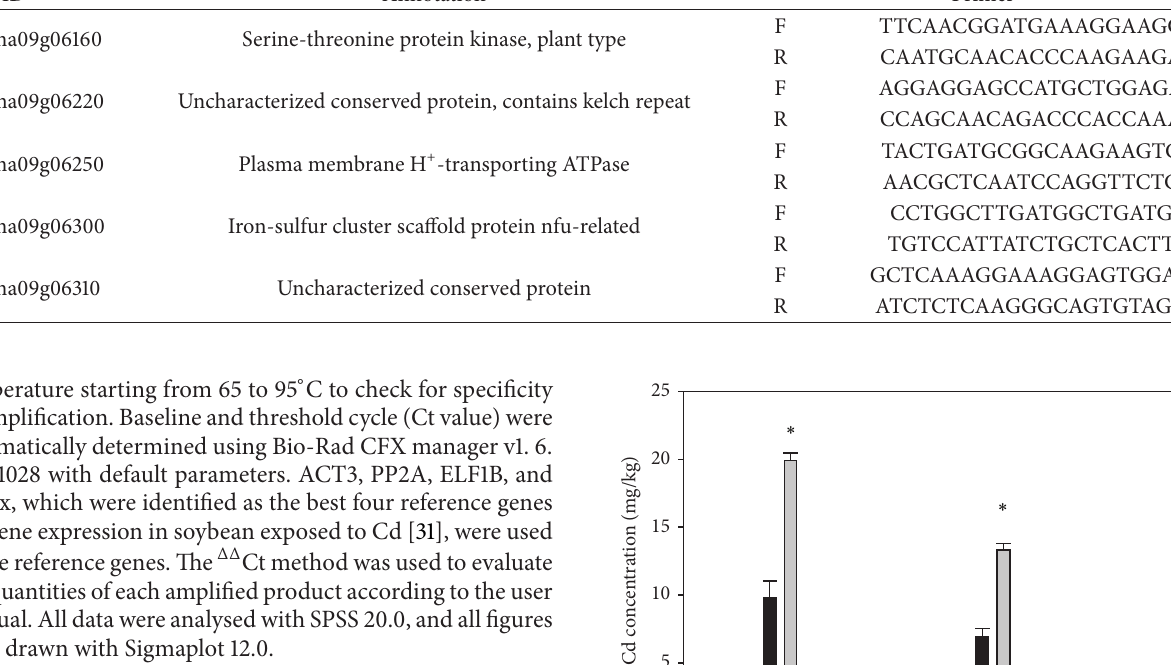
Table 1: The genes located in original region of major locus Cda1 or QTL were analyzed for expression pattern. Loci ID